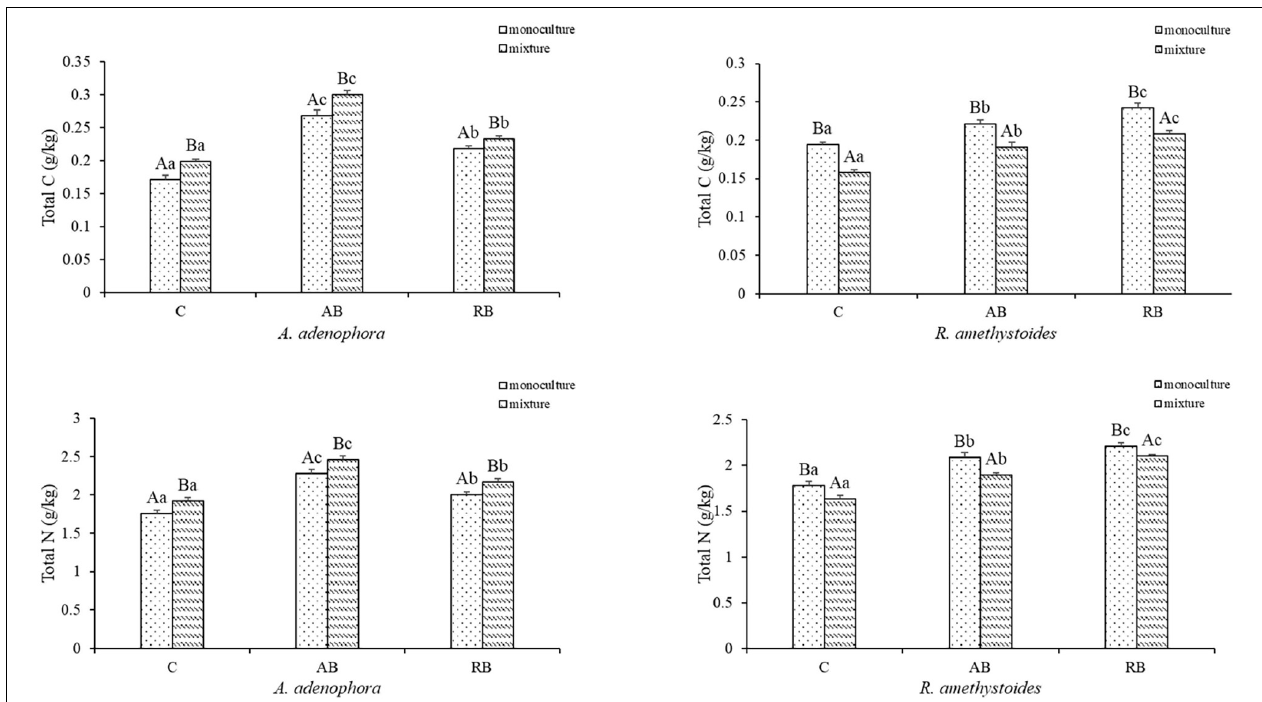
FIGURE 4 | Effect of Bacillus on plant total carbon and nitrogen concentrations of invasive plant A. adenophora and native plant R. amethystoides when grown in monoculture or in mixture. Different lowercase letters indicate significant differences among the inoculation treatments at p < 0.05. Different capital letters indicate significant differences between the monoculture and mixture at p < 0.05. Error bars represent ± 1SE of the mean ( n = 5).